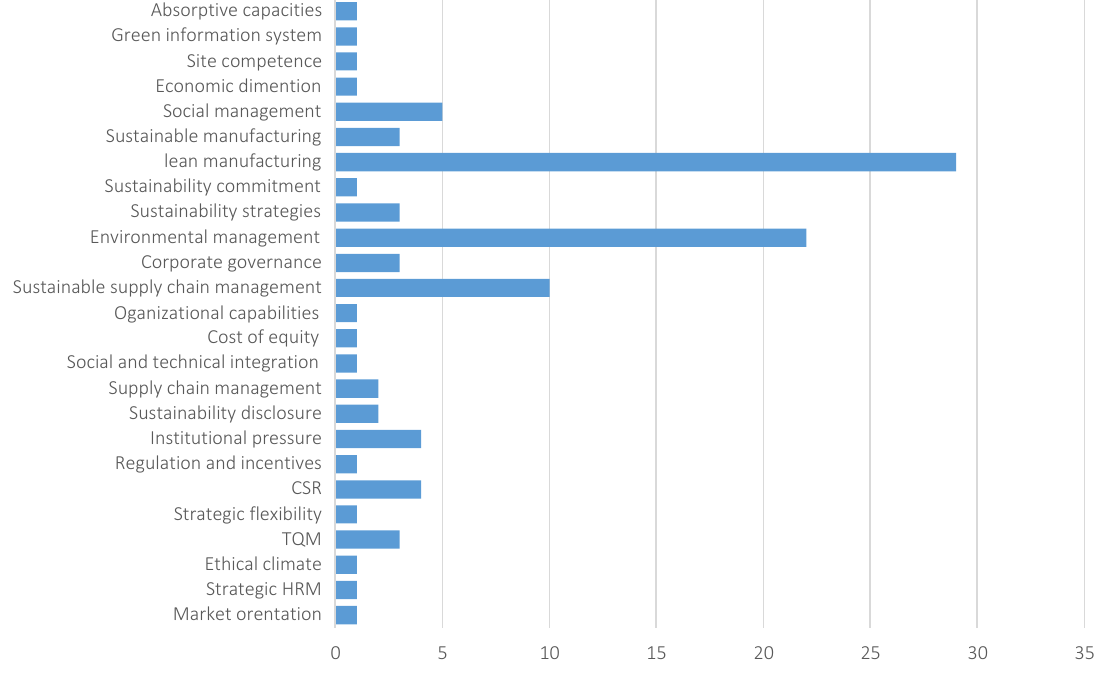
Figure 3. Sustainability antecedents